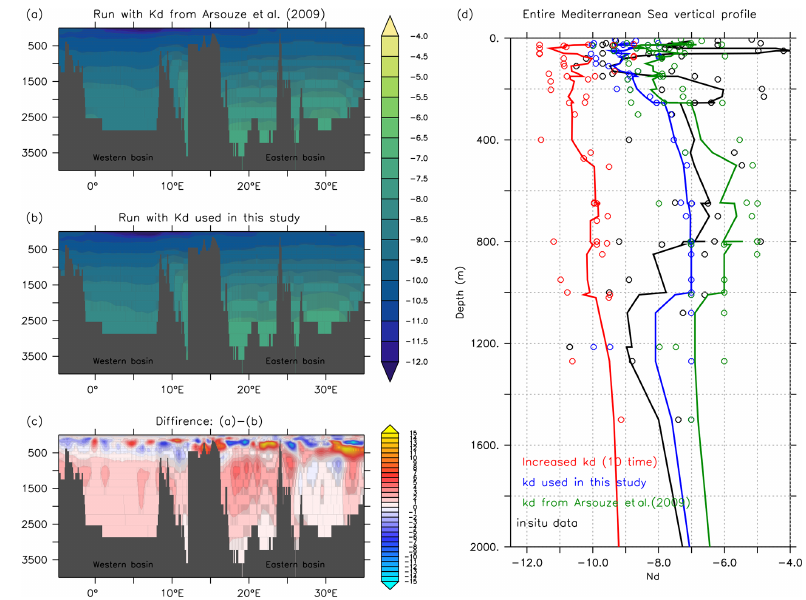
Figure A2. Same as Fig. A1 but for ε Nd (in ε Nd